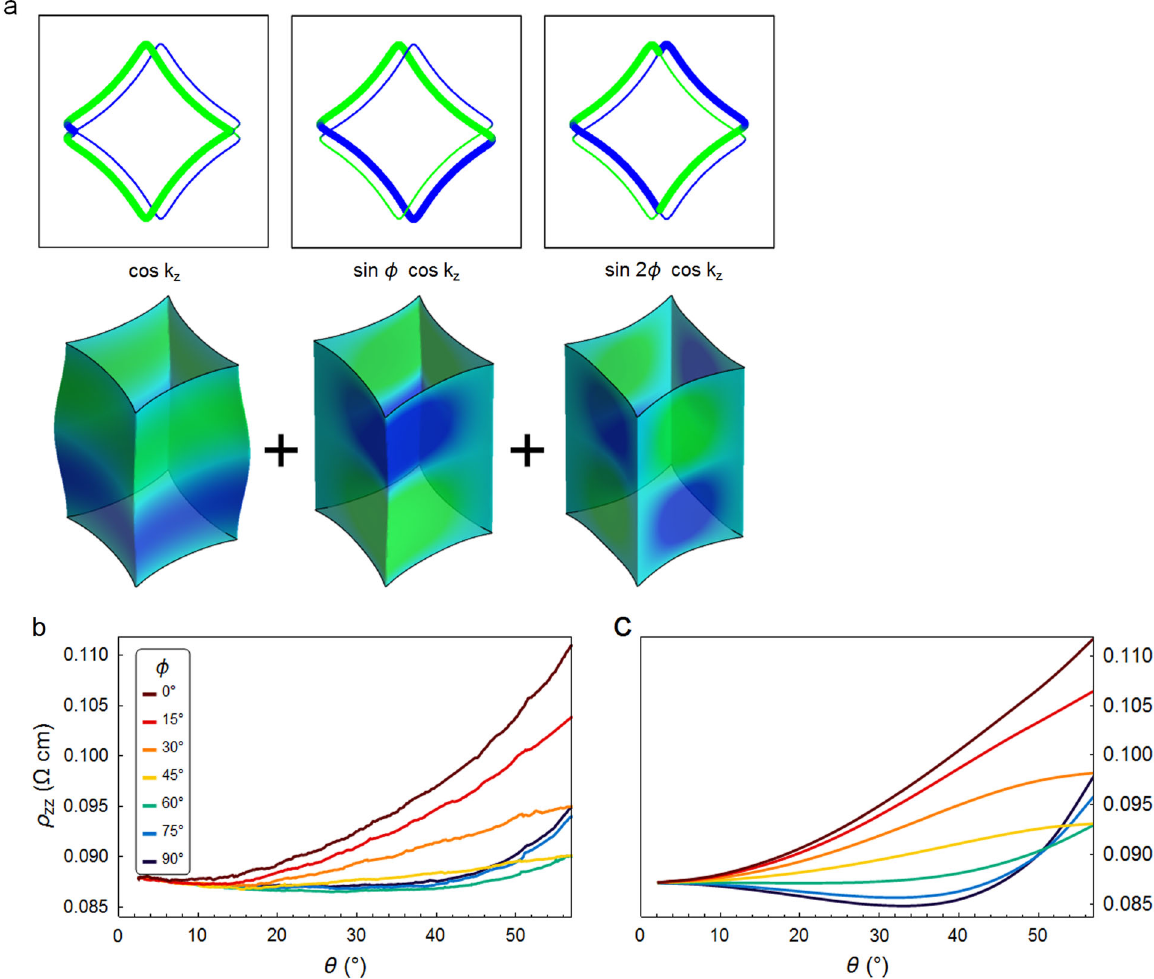
Fig. 4 Simulated magnetoresistance from a single bilayer-split pocket inYBa 2 Cu 3 O 6.58 . The model Fermi surface consists of three dominant breakdown sections ( a ) that combine the in-plane diamond geometry of Fig. 3 with the interlayer dispersion symmetries of Fig. 2b (which were shown with isotropic k F to emphasize their symmetry). The raw magnetoresistivity data is reproduced in panel b , truncated at θ = 58° at the onset of superconductivity. Panel c is a simulation of this data using the three magnetic breakdown orbits contributing to the dominant QO frequency, which have symmetries shown in Fig. 2b. The strongest contribution comes from the cylinder with sin ϕ cos k z warping, which explains the dominant C 2 symmetry we observe in the